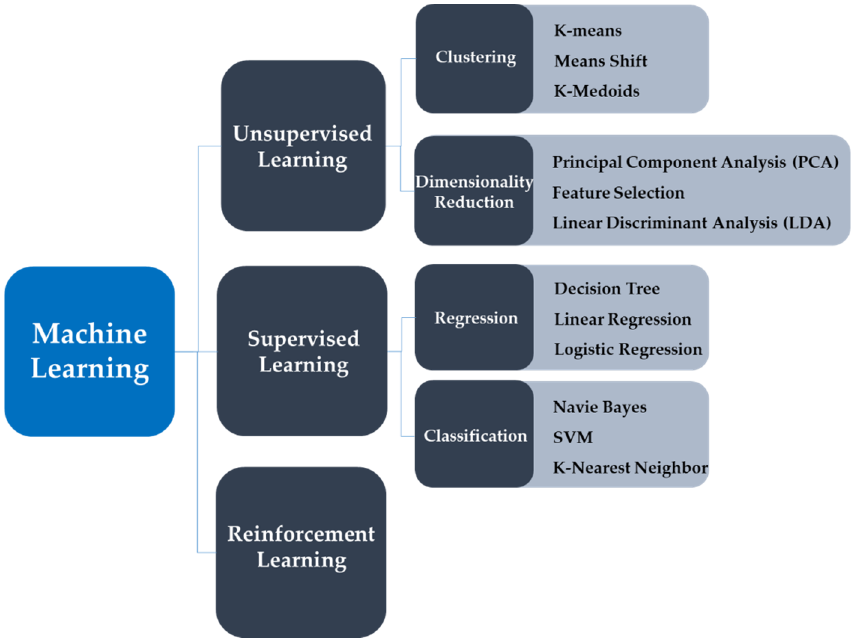
Figure 1. Types of machine learning algorithms [31].